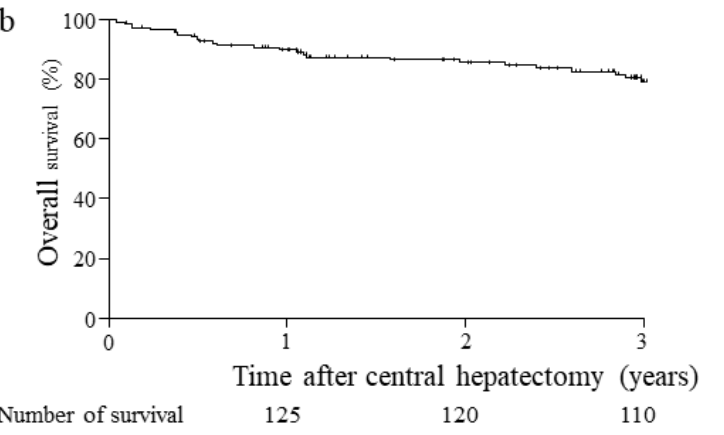
Figure 3. Number of patients who survived are indicated. Tumor recurrence-free survival ( a ) and overall survival ( b ) within three years in 138 HCC patients who underwent CB, except four cases of in-hospital deaths after CB. CB, central bisectionectomy; HCC, hepatocellular carcinoma.